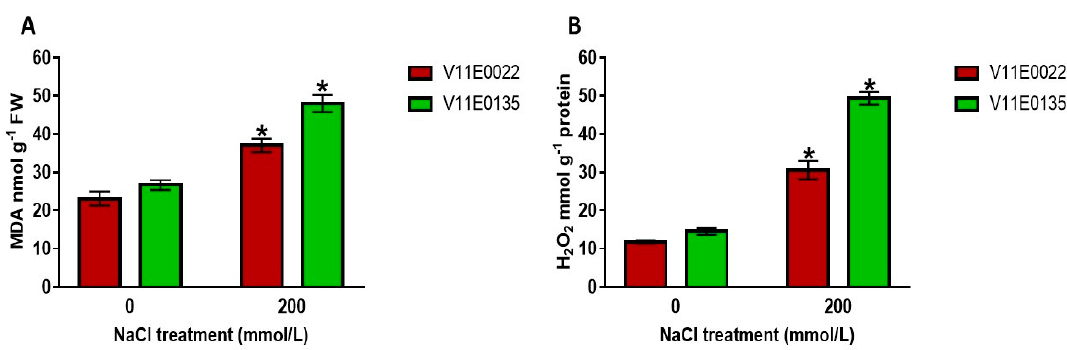
Figure 3. Effect of salt stress on malondialdehyde (MDA) ( A ) and reactive oxygen species (ROS) production ( B ) in water dropwort cultivars. Bars with the asterisks (*) indicate the significant difference ( p < 0.05) between the control and its respective treated samples. Values are means ± SD.